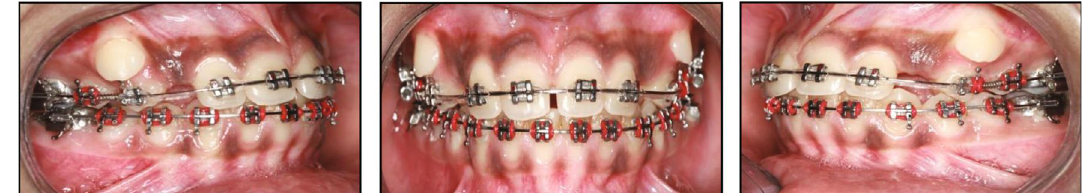
Figure 7: Nitinol coil spring between upper and second premolar.